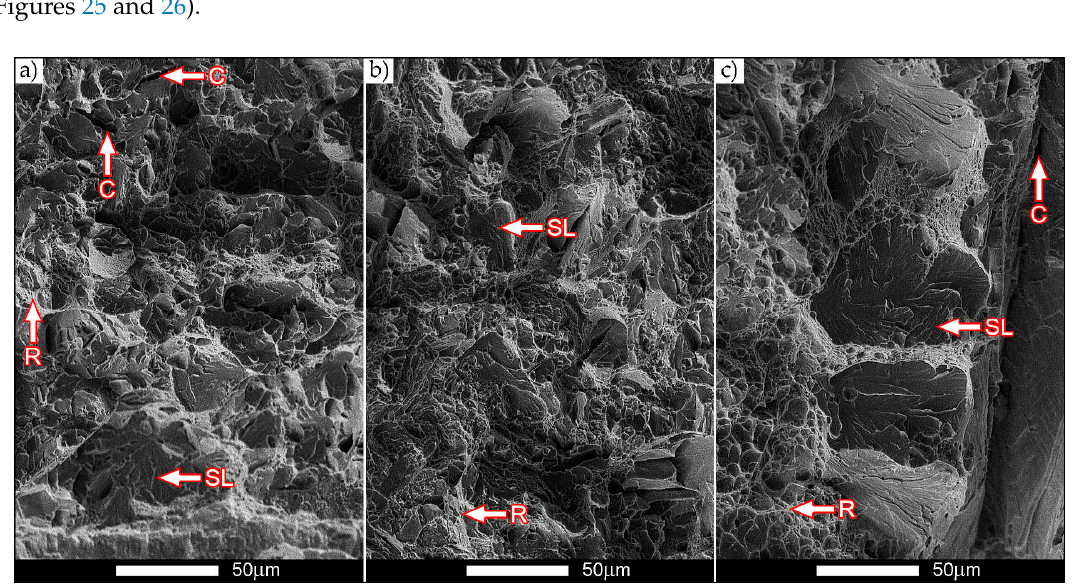
Figure 24, after impact testing at +20 ° C. ( a ) Area marked with the frame A1; ( b ) area marked with the frame B1; ( c ) area marked with the frame C1. R—“river” system; SL—slides; C—microcracks with fine